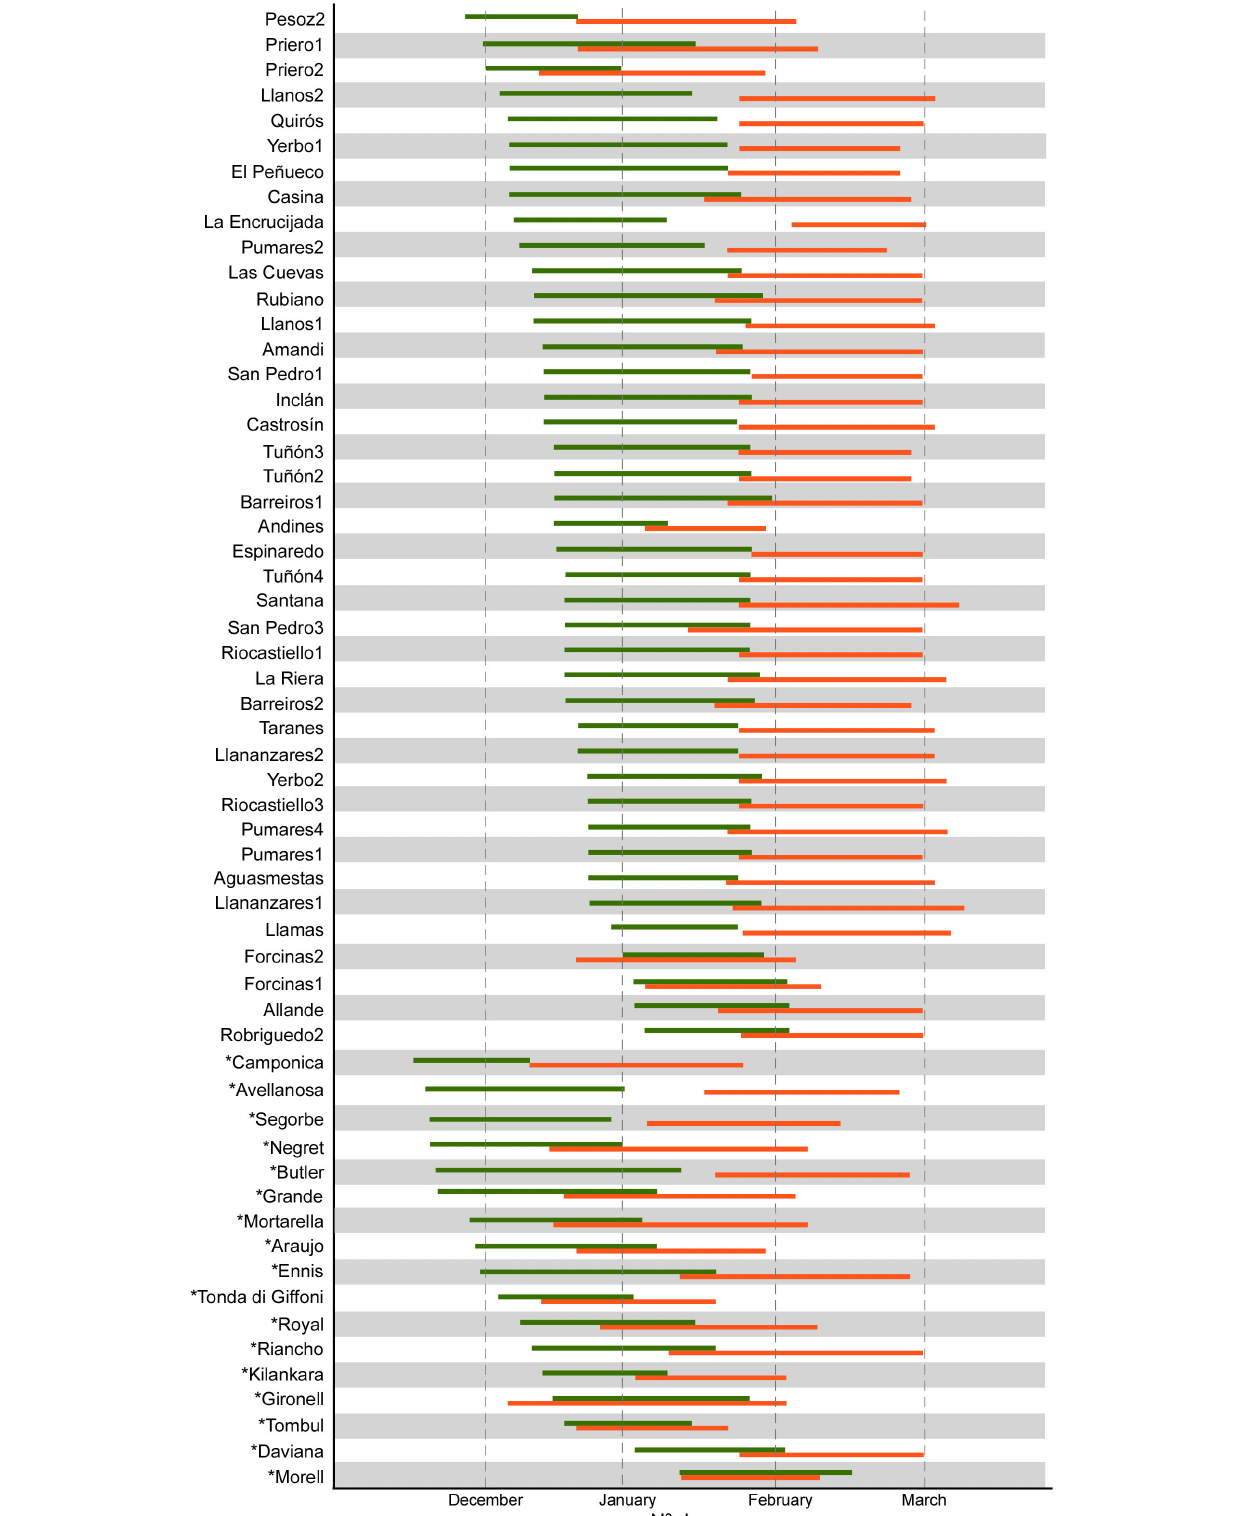
Frontiers in Plant Science |